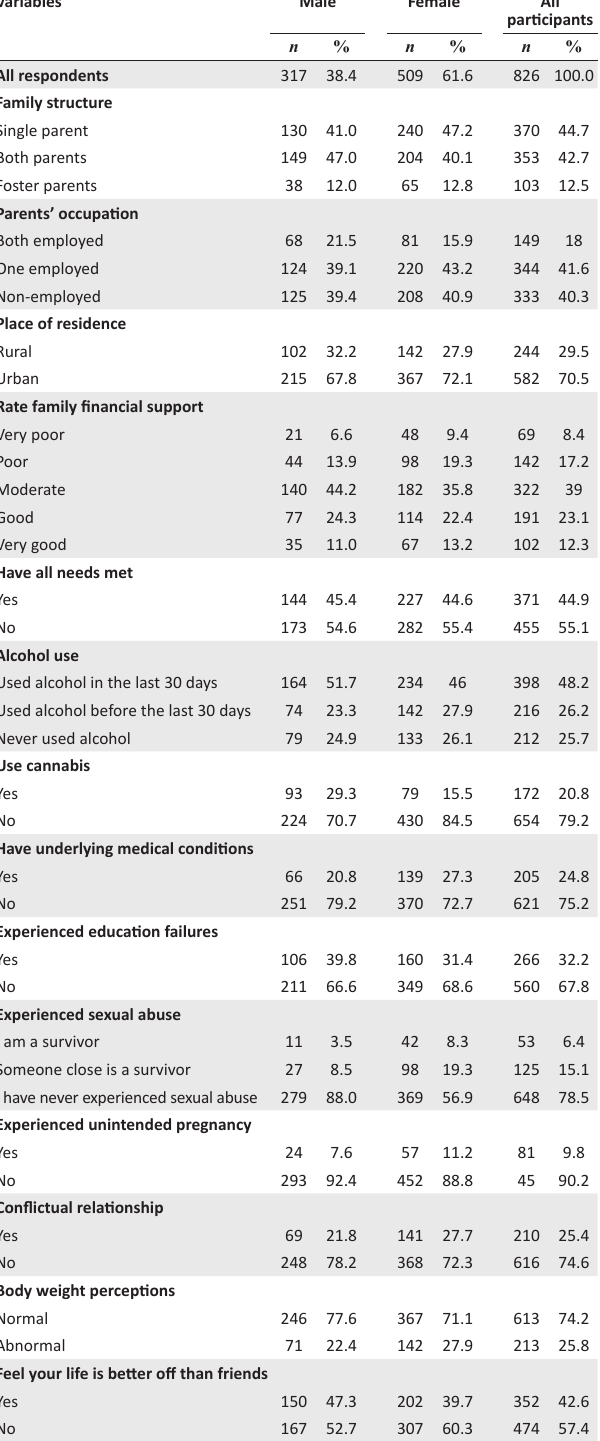
TABLE 2: Multiple logistic regression model analysis showing factors associated with suicidal